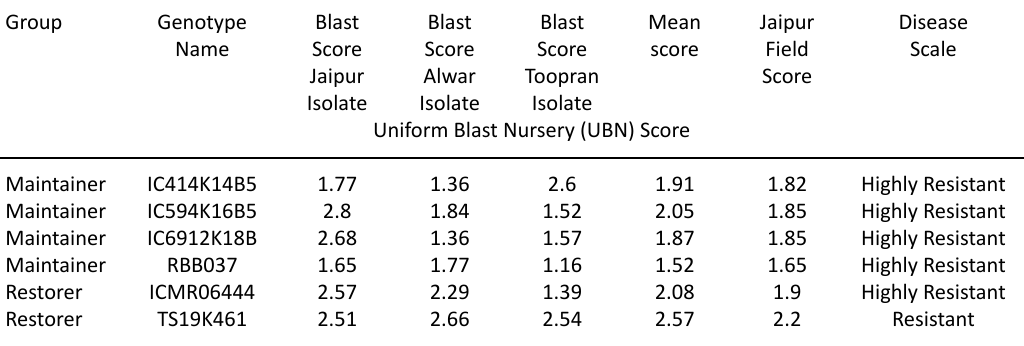
table 2. Resistant Genotype Blast Scores in UBN and Field Condition Group